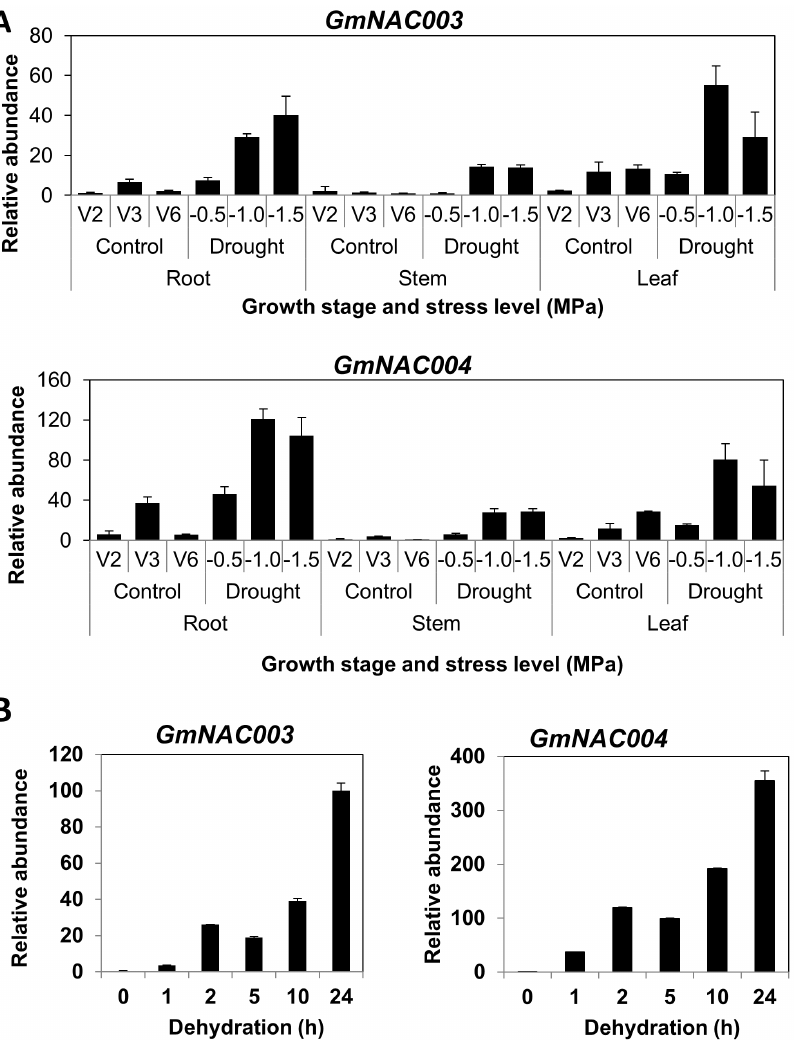
Figure 1. Relative transcript abundance of GmNAC003 and GmNAC004 in response to water stress. Transcript abundance was quantified using qRT-PCR and the data were normalized to the four best internal control genes ( CYP2, IDE, UNK1 and UNK2 ) based on the M stability of GeNorm analysis. Mean relative expression levels were transformed to a value of 1 for the sample having lowest expression. Error bars are standard errors of the means from three replications. (A) Response to water deficit stress. Plants at the 2-leaf (V2) growth stage were allowed to grow without supply of additional water until desired stem water potentials were achieved. V2, V3 and V6 are the growth stages of the control plants corresponding to the time when water stressed-plants were sampled. (B) Response to dehydration stress. V2 growth stage plants were harvested and allowed to dehydrate in a growth chamber for the designated times.